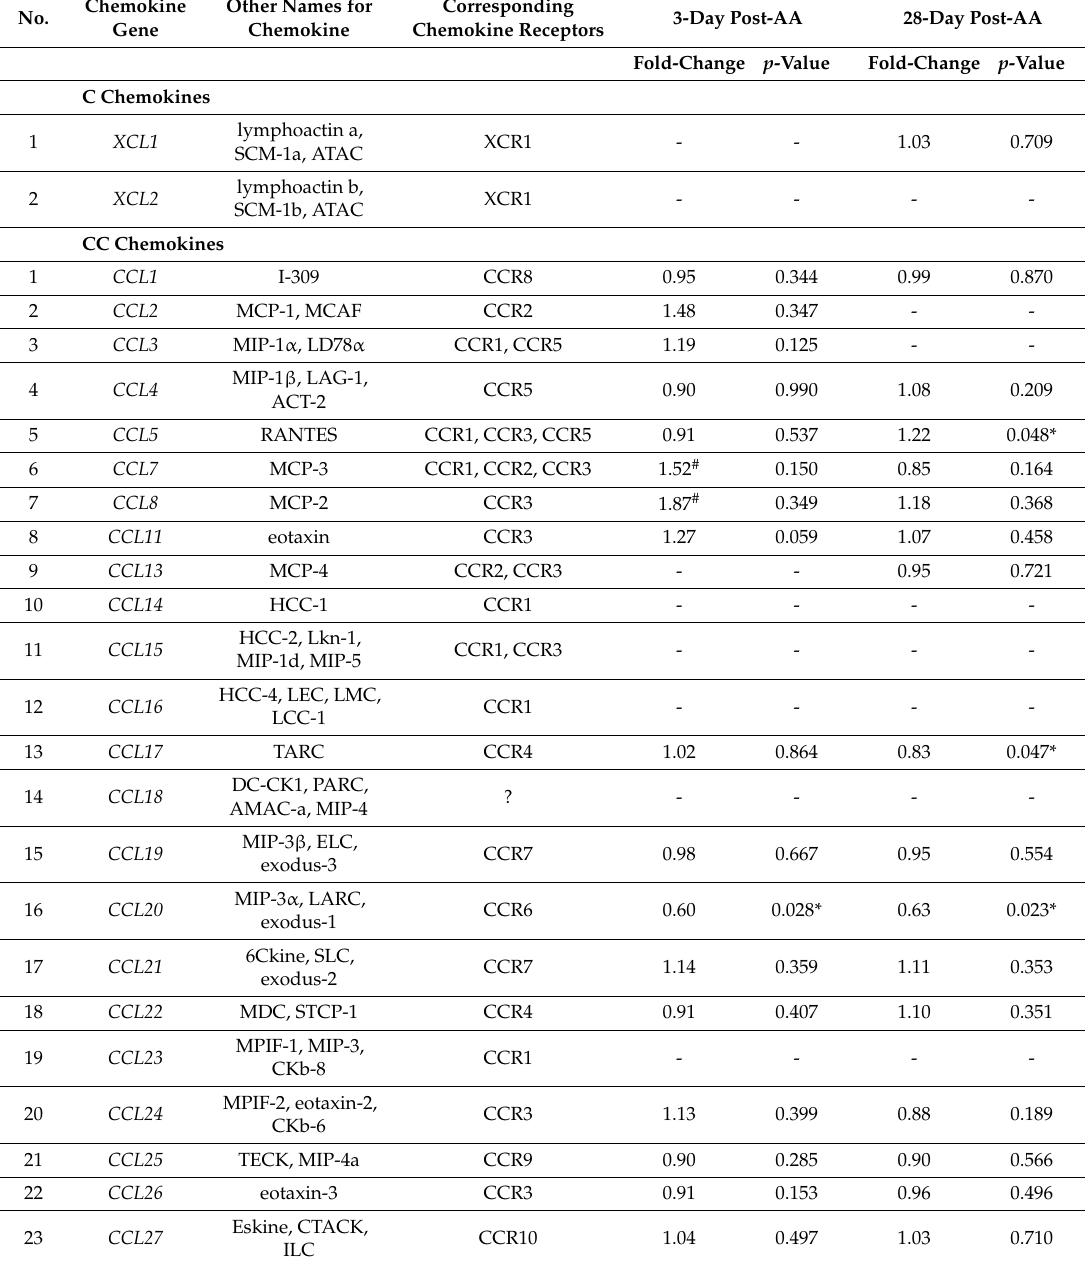
Table 1. Individual distal colonic gene expression described chemokine genes three days post-AA and 28 Days